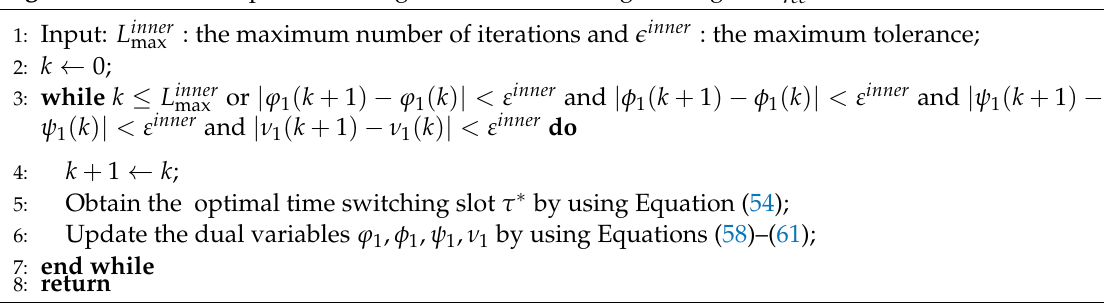
Algorithm 5 Inner Loop Iterative Algorithm for obtaining τ ∗ for given η TS